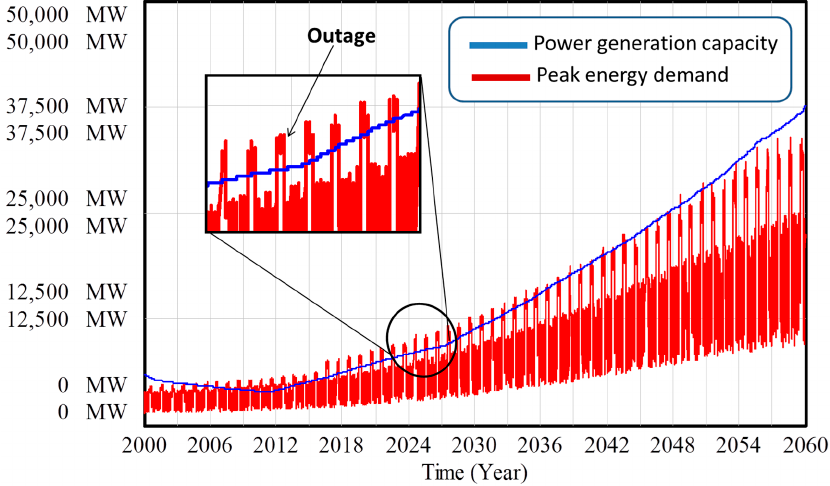
Figure 5. Regular management. Under the regular management, we can see that outages appear (mainly during the summer). An outage occurs when the peak energy (in red) demand is higher than the power generation capacity (in blue). the power generation capacity (in